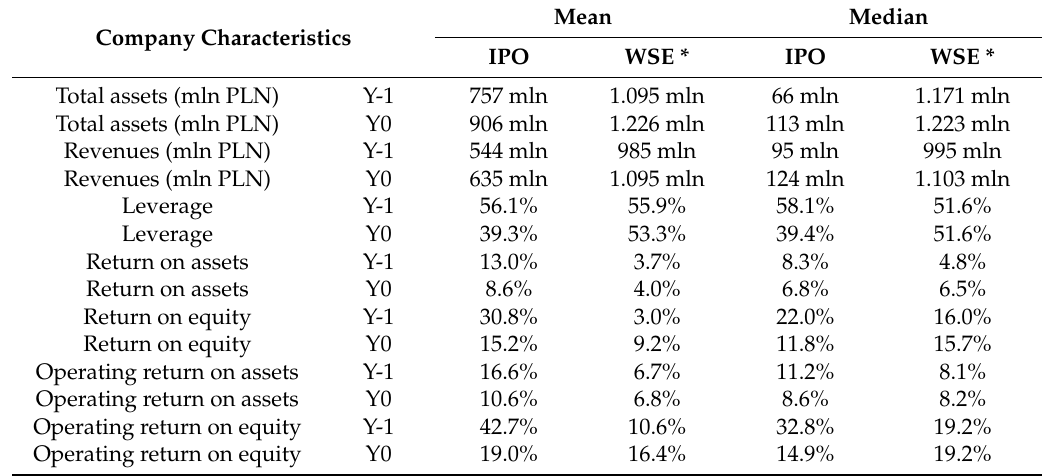
Table 1. Descriptive